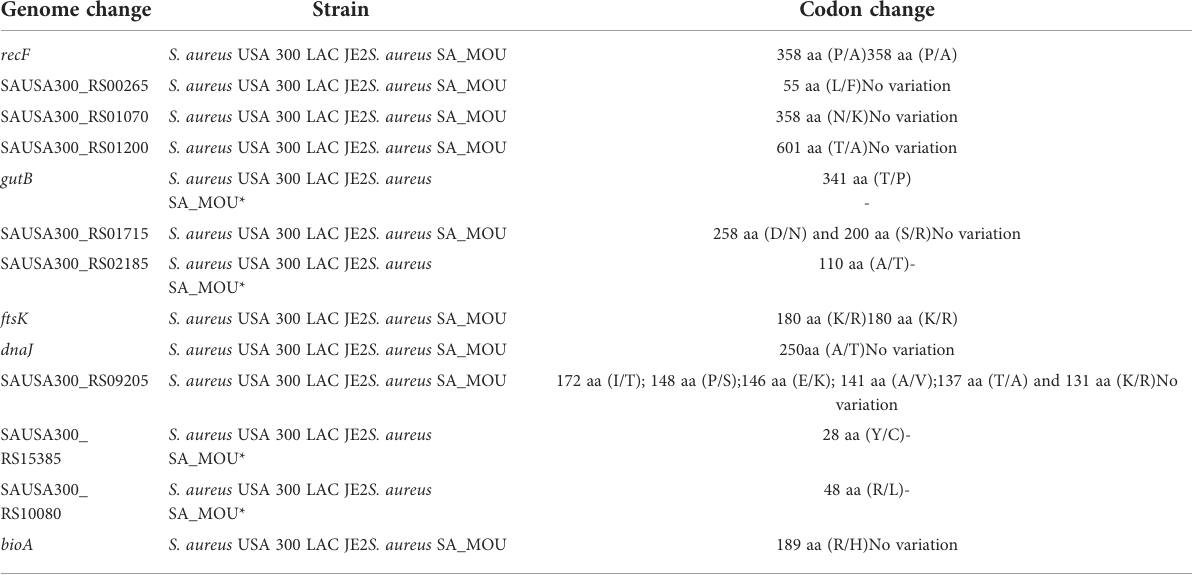
*Locus not identi fi ed in the assembled SA_MOU genome SNPsobserved ingenomic pools(3x10 isolates)from colonization isolatesthat persisted across threerepeated nasopharyngeal passages (USA 300LACJE2)anda presumed nasopharynx mouse-adapted strain (SA_MOU; 10